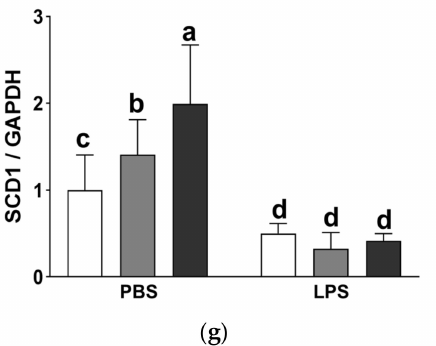
Figure 7. Effects of partial replacement of dietary fat with krill oil or coconut oil on the hepatic lipid contents and mRNA expression of lipogenesis-related genes in rats after the LPS challenge. Sprague Dawley rats were fed either a high-fat diet (HFD), HFD partially replaced with krill oil (HFD + KO), or coconut oil (HFD + CO) for 10 weeks, and then treated with PBS or LPS (1 mg/kg) for 24 h. ( a ) Hepatic triglyceride content, ( b ) hepatic total cholesterol content, ( c ) fatty acid synthase (FAS), ( d ) glucose-6- phosphate dehydrogenase (G6PD), ( e ) acetyl CoA carboxylase (ACC), ( f ) CCAAT/enhancer-binding protein alpha (C/EBP- α ), and ( g ) stearoyl-CoA desaturase-1 (SCD1) mRNA expression levels were measured. Values are presented as means ± SD; n = 8 per individual group. Data were analyzed by two-way ANOVA followed by Tukey’s multiple comparisons test to determine the interactions or the main effects (diet and LPS stimulation). Asterisk indicates a significant main effect for LPS (*** p < 0.001, **** p < 0.0001). Pound indicates a significant main effect for LPS ( # p < 0.05). Labeled means without a common letter differ significantly, p < 0.05. HFD, high-fat diet; HFD + KO, high- fat diet + krill oil; HFD + CO, high-fat diet + coconut oil; PBS, phosphate-buffered saline; LPS,